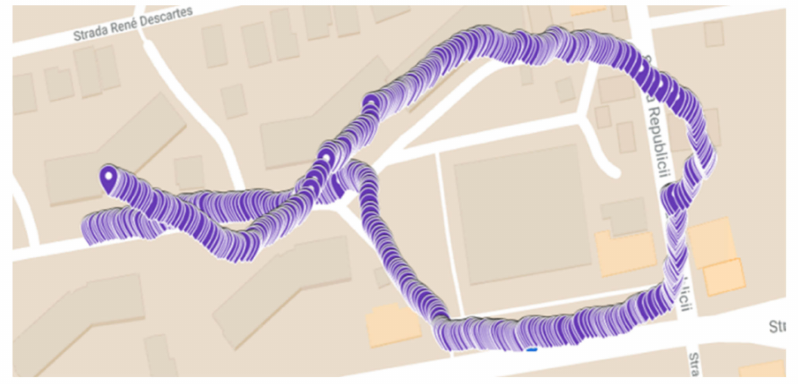
Figure 3. GPS locations provided by Adafruit Ultimate